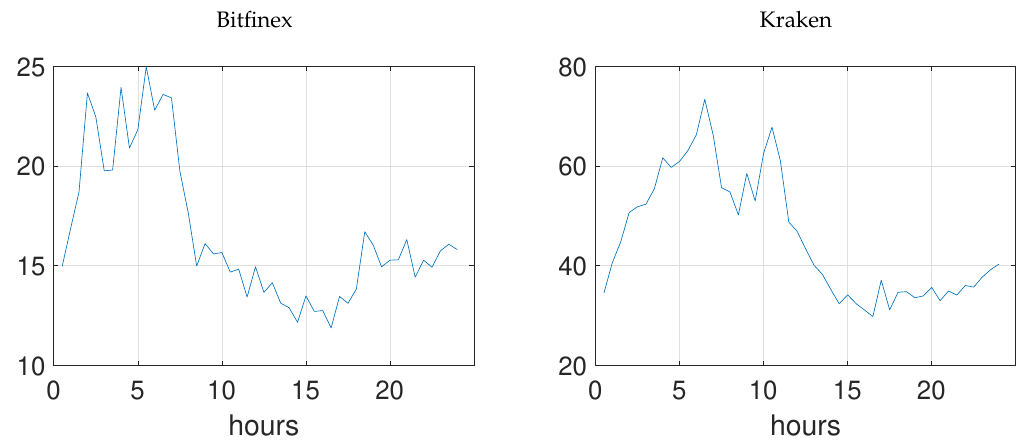
Figure 4. Average price duration during the day. Note. The figure presents the intraday evolution of average price durations based on 30 min intervals on the full period for Bitfinex (left plot) and Kraken (right plot).